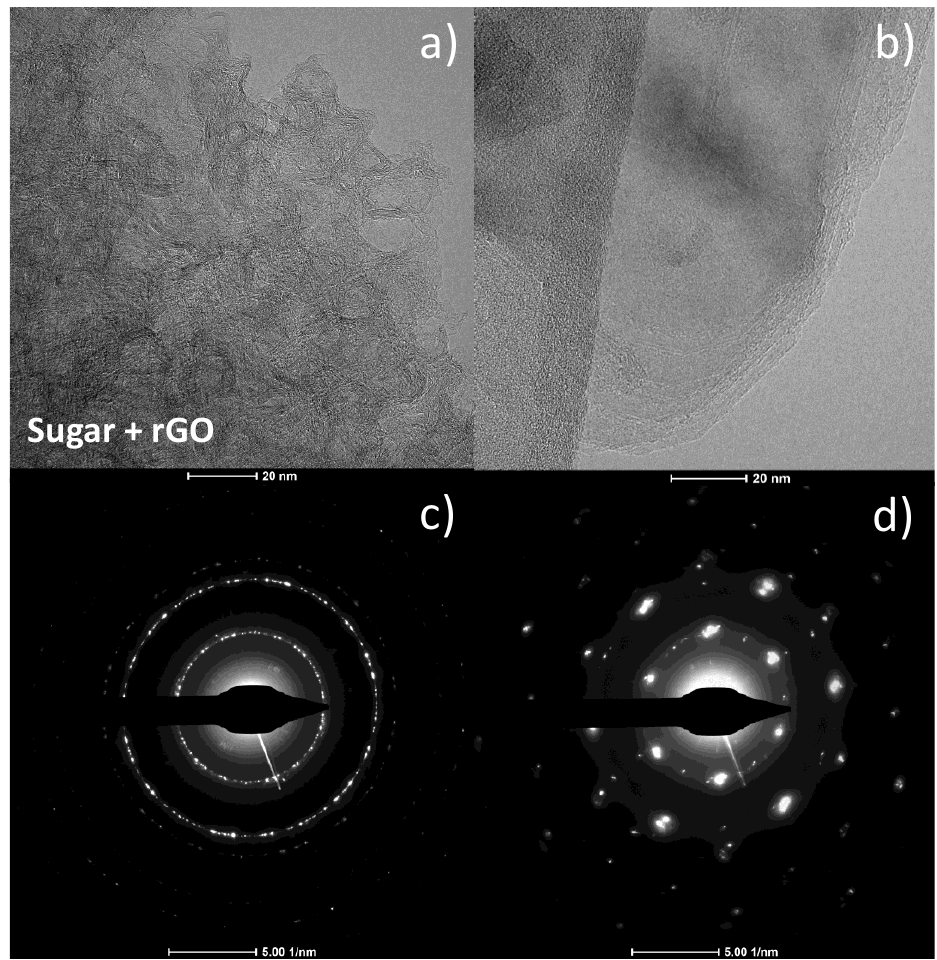
Figure 5. ( a , b ) HRTEM images and ( c , d ) SAED patterns for the phases observed in the sugar + rGO C-C composite. ( a , c ) correspond to the phase with randomly oriented crystals, while ( b , d ) correspond to the phase with sheet-like graphitic unidirectional crystallinity.